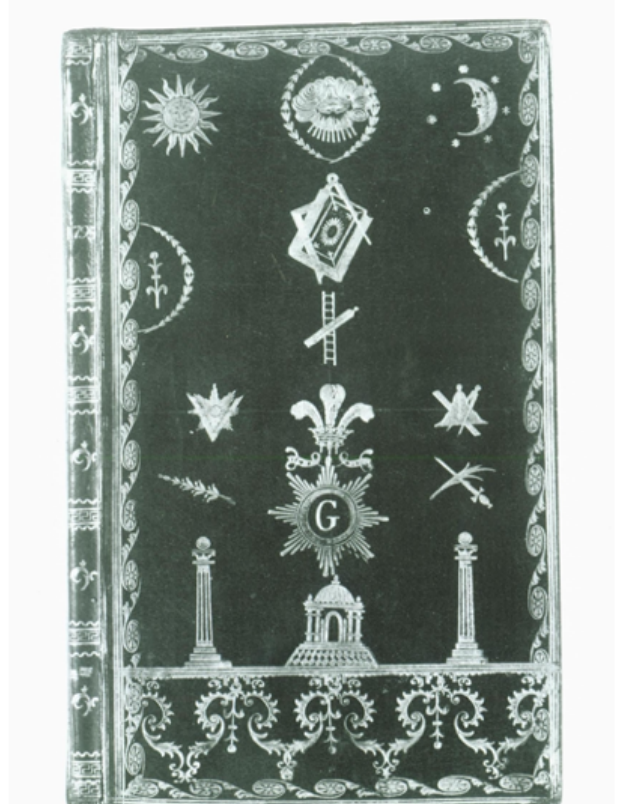
Fig. 40. Maggs Brothers Ltd, Bookbinding in the British Isles Sixteenth to the Twentieth Century, Volume 1, Catalogue 1075 (London, 1987), item 250. 144 With thanks to Maggs Brothers